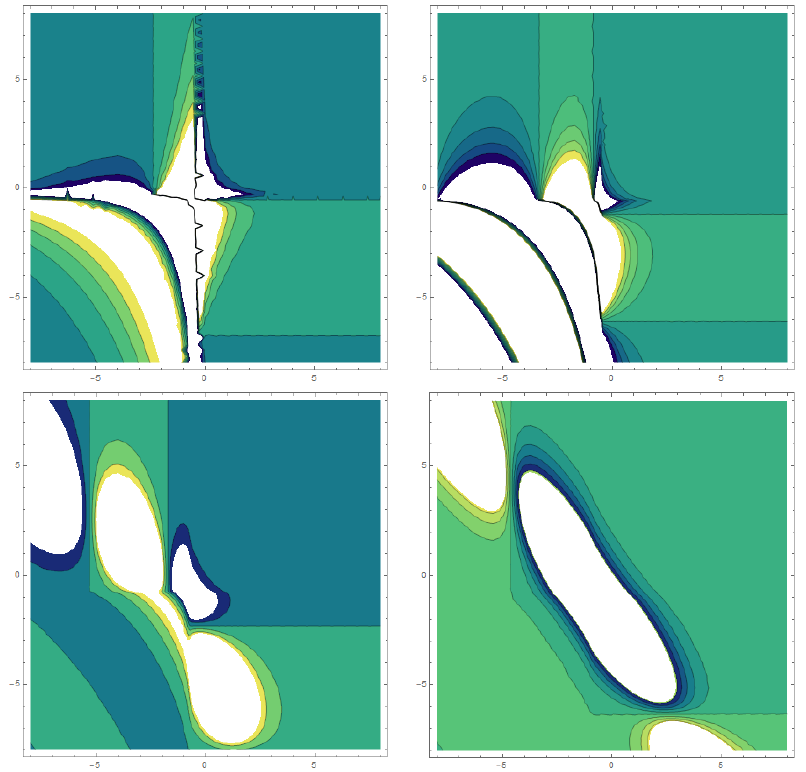
Figure 9. | L 6 | across different values of β . That illustration portrays a realistic representation of | L 6 ( t , x ) | , which is linked to the category of dark solitary-wave solutions. Here is a visual showing a 2D contour spanning the range ( − 0.8, 0.8 ) for various values of β associated with parameters, such as ρ = e